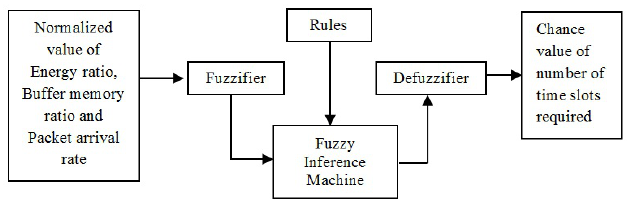
Figure 3. Block diagram of fuzzy